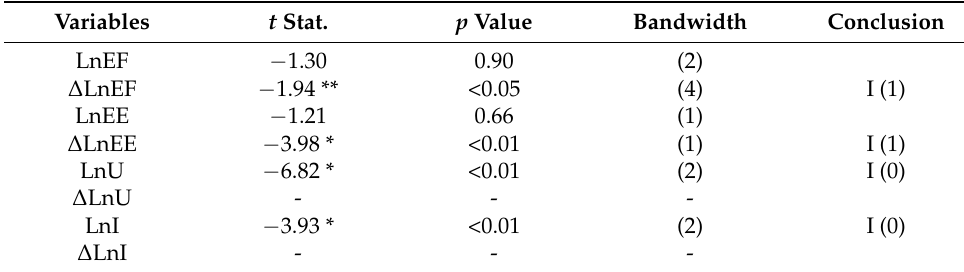
Table 6. Results of Levin Lin (LL)